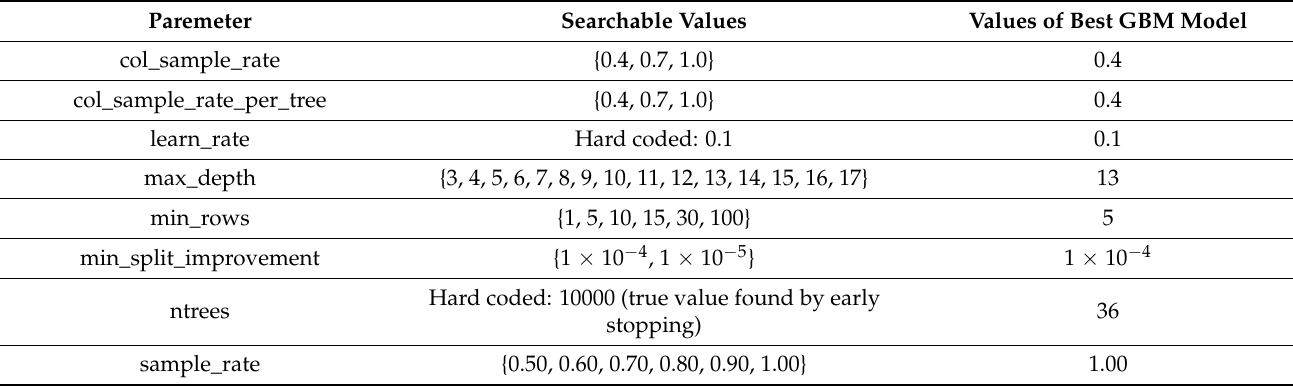
Table A3. Tuning parameters for GBM: Gradient Boosting Machine in AutoML run. Values of best GBM model are for 2-class scenario with VSURF ‘interpretation step’ feature